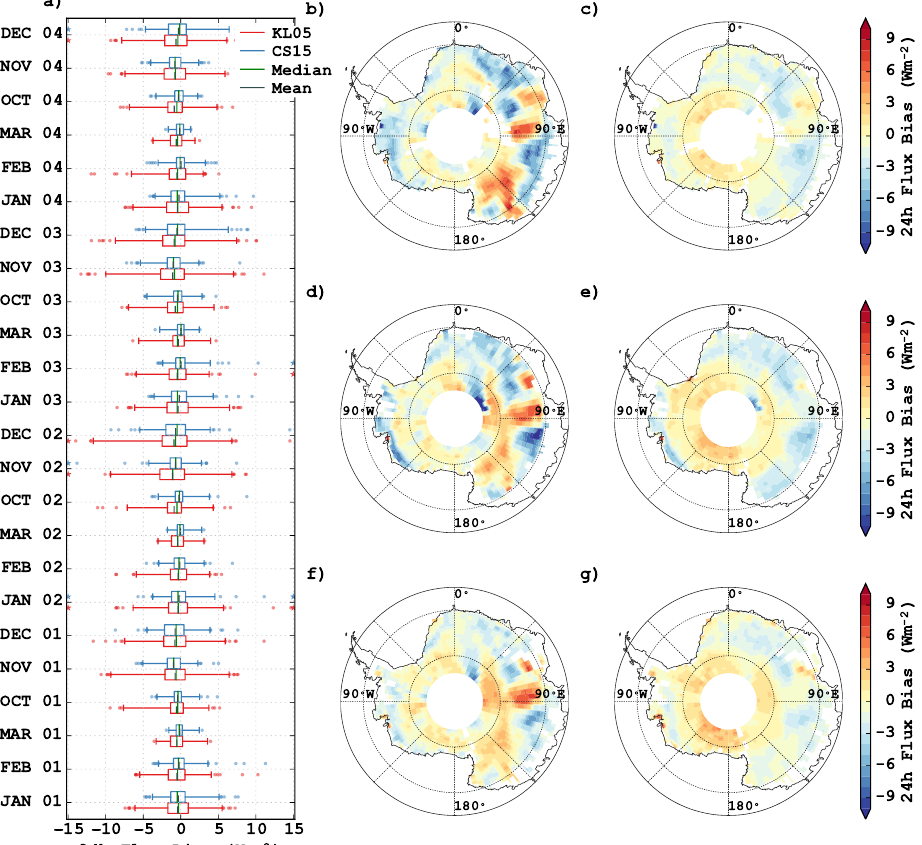
Figure 9. (a) Box and whisker comparison of grid-box mean 24h flux biases (Wm − 2 ) (see Eq. 6) for the months October–March for 2001–2004. The whiskers show the 0.5–99.5 percentile range of the biases for each year, the boxes show the interquartile range (25th–75th percentile range), and the dots show the outliers. Stars indicate that there are values outside the axis range. Medians are shown by the green line and means by the grey line. The 24h flux biases calculated using the KL05 ADMs are shown in red and those calculated using the CS15 ADMs (this study) are shown in blue. (b) – (g) show maps of the grid-box biases for November 2002 (b, c) , December 2002 (d, e) , and January 2003 (f, g) . The middle column (b, d, f) shows maps of the bias calculated using the KL05 ADMs, and the right column (c, e, g) shows the bias maps when using the CS15